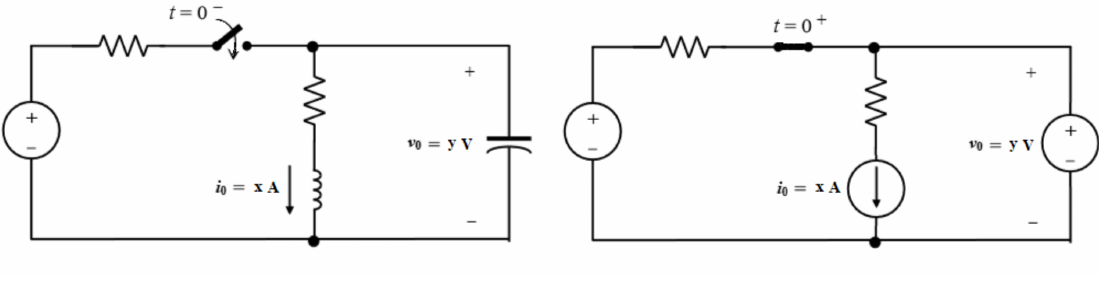
Figure 14. Initial state